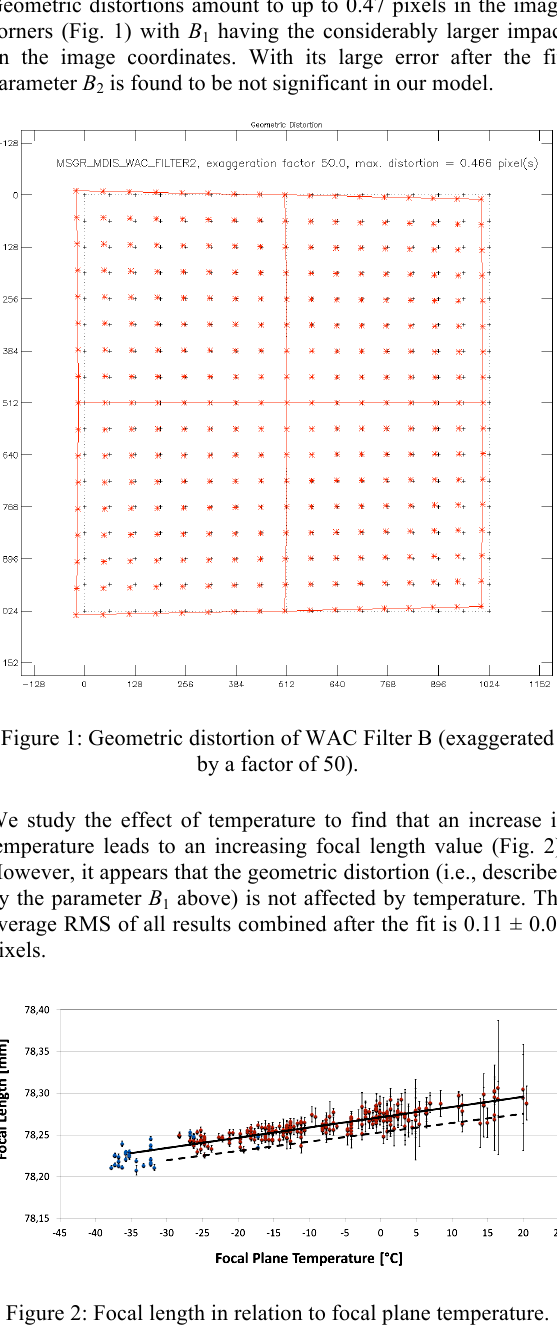
Figure 2: Focal length in relation to focal plane temperature. Error bars depict focal length accuracy after the fit. Results from images taken during the cruise are shown in blue; results from orbit are shown in red. Solid black line shows our linear function, while the dashed line is based on results given in (Denevi et al.,